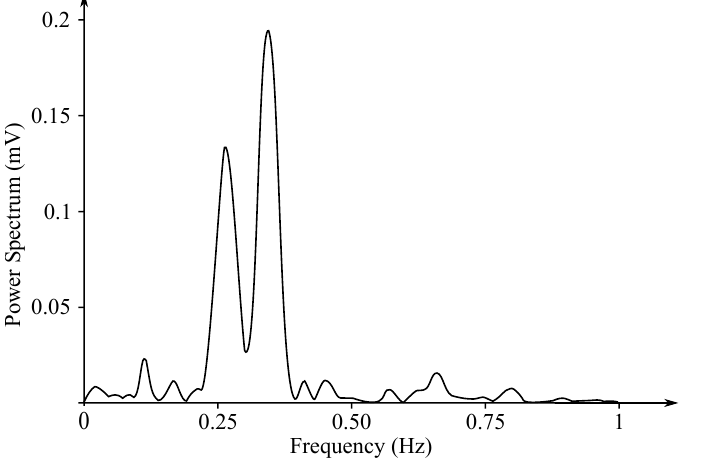
Figure 15. Power spectrum of the first contraction from the Figure 14.